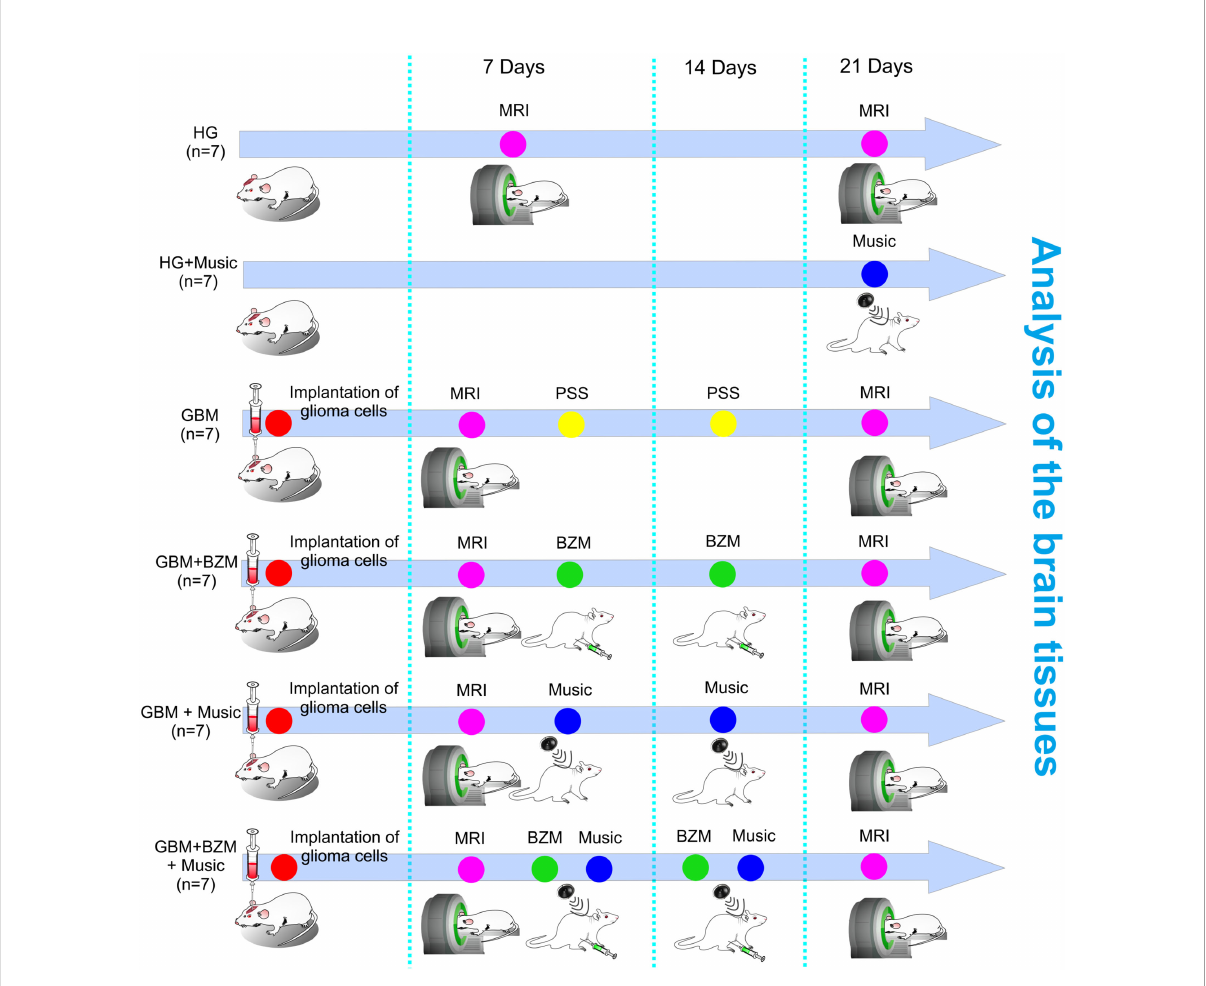
FIGURE 1 Schematic illustration of the design of the experiments. The rats were divided into six groups: (1) GBM, the group included rats with GBM and received intraperitoneal injection of PSS; (2) GBM+Music, the group included rats with GBM and the music-induced BBB opening; (3) GBM +BZM, the group included rats with GBM and received intraperitoneal injection of BZM; (4) GBM+BZM+Music, the group included rats with GBM treated by music and received intraperitoneal injection of BZM; (5) HG, the group included healthy sham rats with the injection of PSS in the same volume and in the same area of the brain, which was selected for the injection of glioma cells; (6) HG + Music, the group included the healthy rats with the music-induced BBB opening; n=7 in each group. The PSS and BZM (10 mg/kg) intraperitoneal injection were performed 7 days and 14 days after the implantation of glioma cells into the rat brain. The MRI analysis of GBM growth and the tumor volume was performed 7 and 21 days post tumor cell implantation. The rats from the GBM+Music and the GBM+BZM+Music groups listened music on 7 and 14 days of tumor growth; rats from the HG group listened music on 21 day of observation. GBM, glioblastoma; BZM, bevacizumab; HG, healthy group; MRI, magnetic resonance imaging; PSS, physiological saline